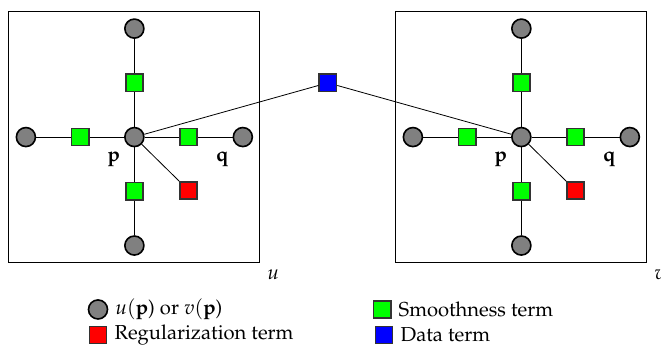
Figure 3. Factor graph representation of the energy minimization functional with de-coupled horizontal and vertical